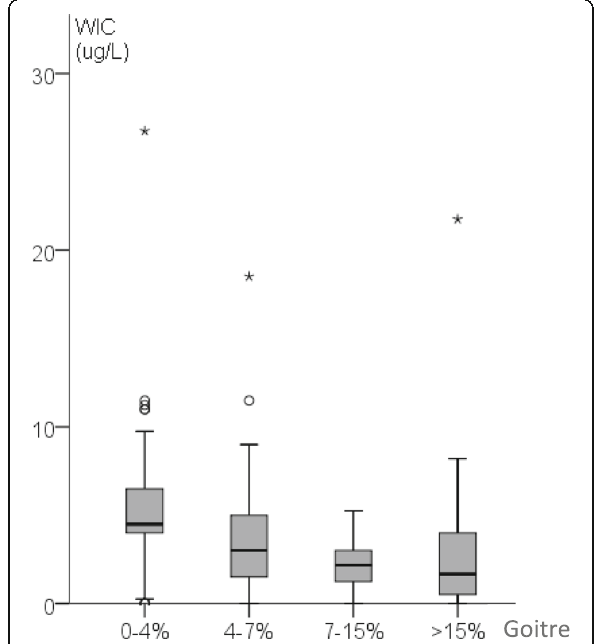
Fig. 3 Relationship between water iodine concentration (WIC) and frequency of goitre in 1929, > 15% goitre vs non-goitre areas ( p = 0.001). o outlier, i.e. value that is 1.5 – 3 times the interquartile range (IQR) higher than the third quartile. * extreme value, i.e. value that is more than 3 times the IQR higher than the third